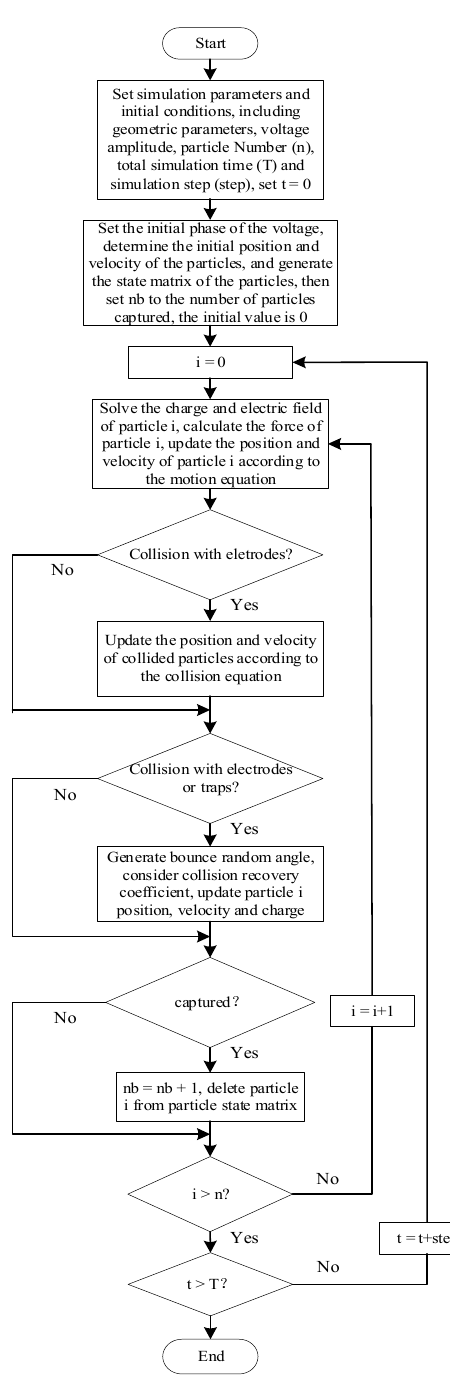
Figure 11. Flow chart of trap optimization simulation.